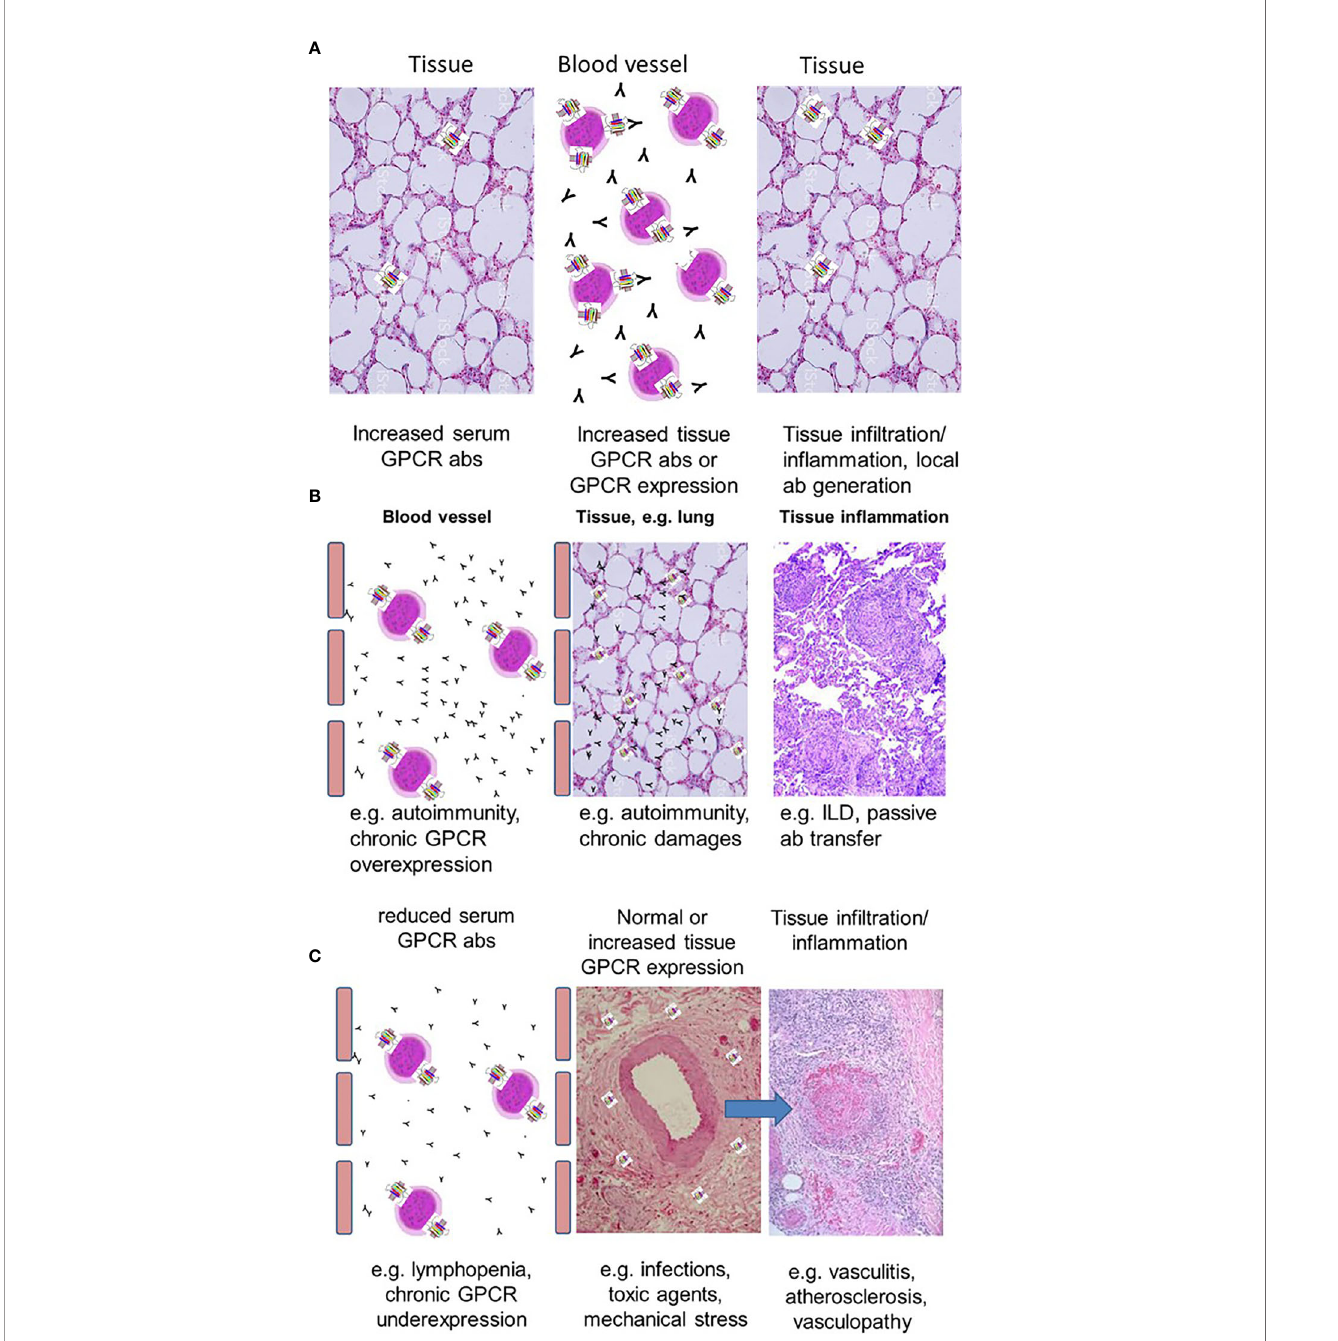
FIGURE 1 | Concepts of altered GPCR abs in tissue in fl ammation. (A) Schematic presentation of a normal immune cell homeostasis with a tight balance between the levels of GPCR abs and GPCR expression of immune cells and tissue-resident cells. (B) Concept to explain tissue in fl ammation by either increased GPCR abs or increased tissue expression of GPCR. (C) Reduced GPCR ab levels could also cause tissue damage based on de fi cient competition to local tissue